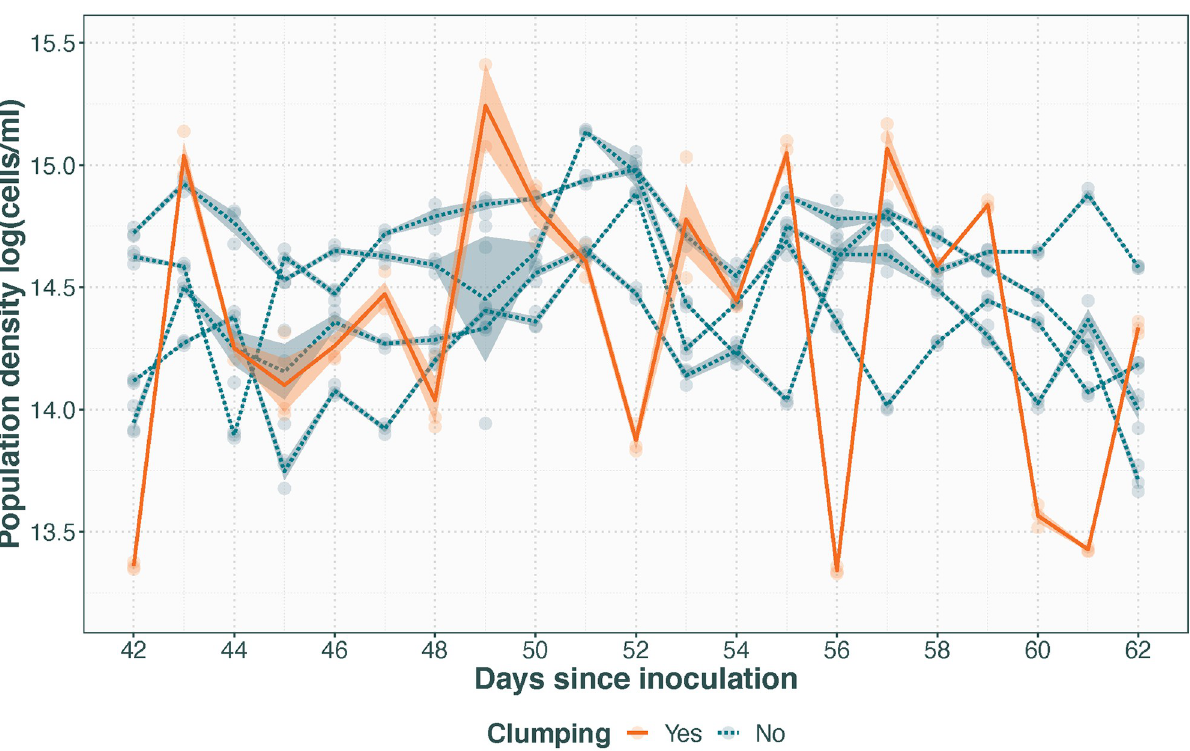
Fig 5. Population density with time in a population exhibiting a clumping phenotype. Clumping population shown with solid line, compared to four other populations receiving the same treatment that did not exhibit clumping in dashed line. Transparent points represent technical replicates, with the lines for population averages with standard